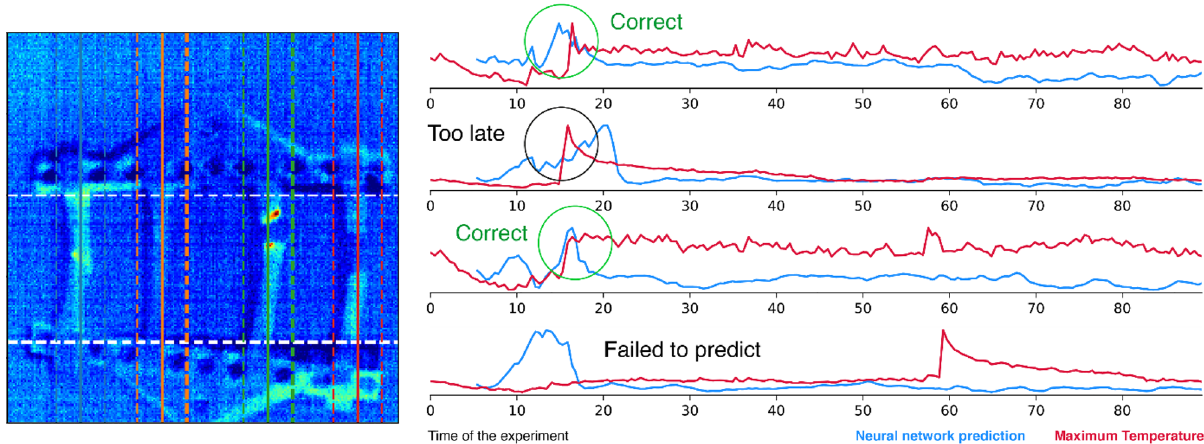
Figure 7. Results of neural network predictions for the case of four samples tested at